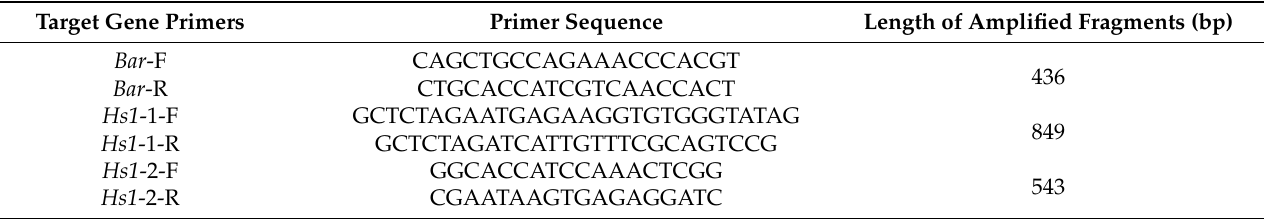
Table 6. Primer pairs for Hs1 pro − 1 , Bar genes known sequences, and length of amplified fragments. Target Gene